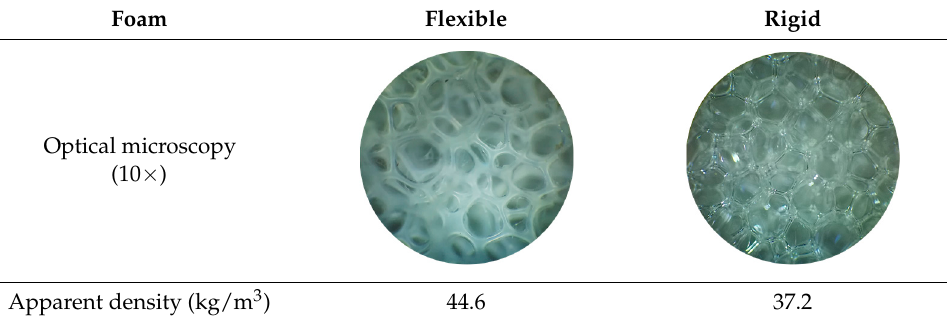
Table 2. General characteristics of the manufactured foams.